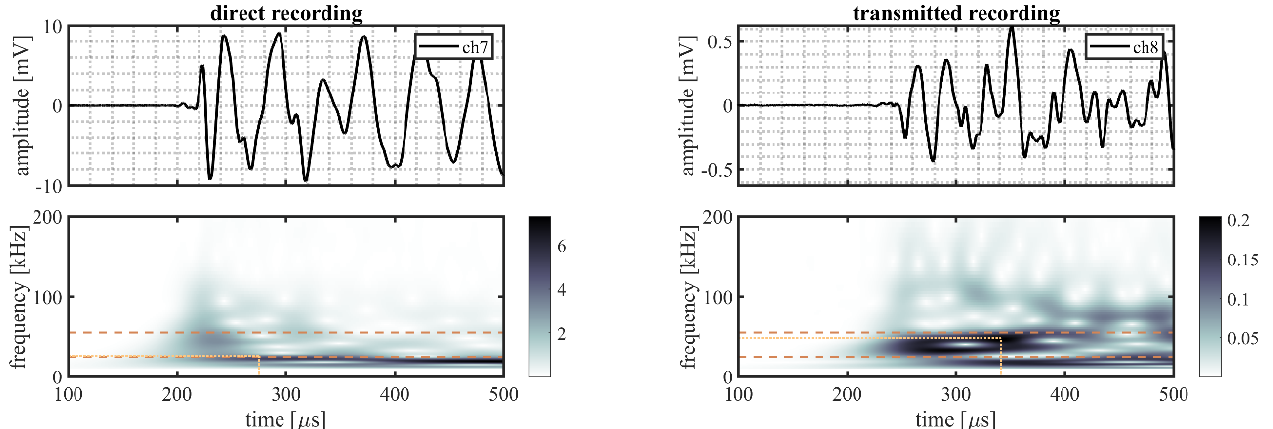
Figure 9. Randomly selected event recorded by R3I-AST sensors, originating from a source location S22, showing the time traces recorded on the outer raceway (ch7, top left ) and on the inner raceway (ch8, top right ), and the time – frequency representation of the recorded signals on the outer ( bottom left ) and the inner ( bottom right ) raceways. The detected magnitude in the time – frequency repre- sentations of the signals is indicated by the intersection of the dotted lines; the dashed lines indi- cate the frequency range of interest (30 – 60 kHz).